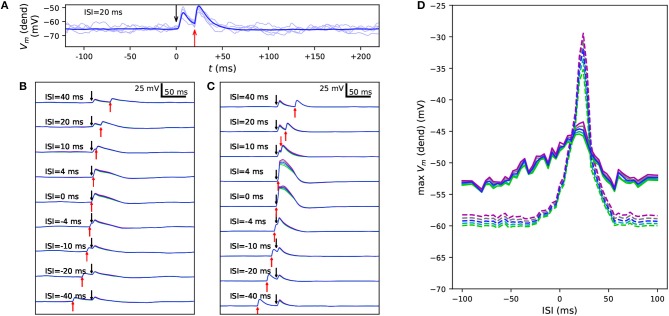
Variants alter the sensitivity to a combination of somatic and apical stimuli during in vivo-like noisy up and down states. (A) Membrane potential time series at the apical dendrite 700 μm from the soma, when the soma is stimulated at 0 ms and the apical dendrite at +20 ms. Thin, dim curves show the same simulation with different random number seeds, and the thick curve shows the mean of 125 repetitions. (B,C) The mean data of panel (A) reproduced with different ISIs during a noisy up (B) or down (C) state. Blue: control, other colors: downscaled versions of a SCN1A variant as in Figures 2, 3. (D) An overview of the up- (solid) and down-state (dashed) data of panels (B) and (C), respectively, as a function of ISI. The y-axis shows the mean apical dendritic membrane potential during a 20-ms interval starting at the onset of the somatic stimulus (0 ms), averaged over 125 repetitions as in (B) and (C).